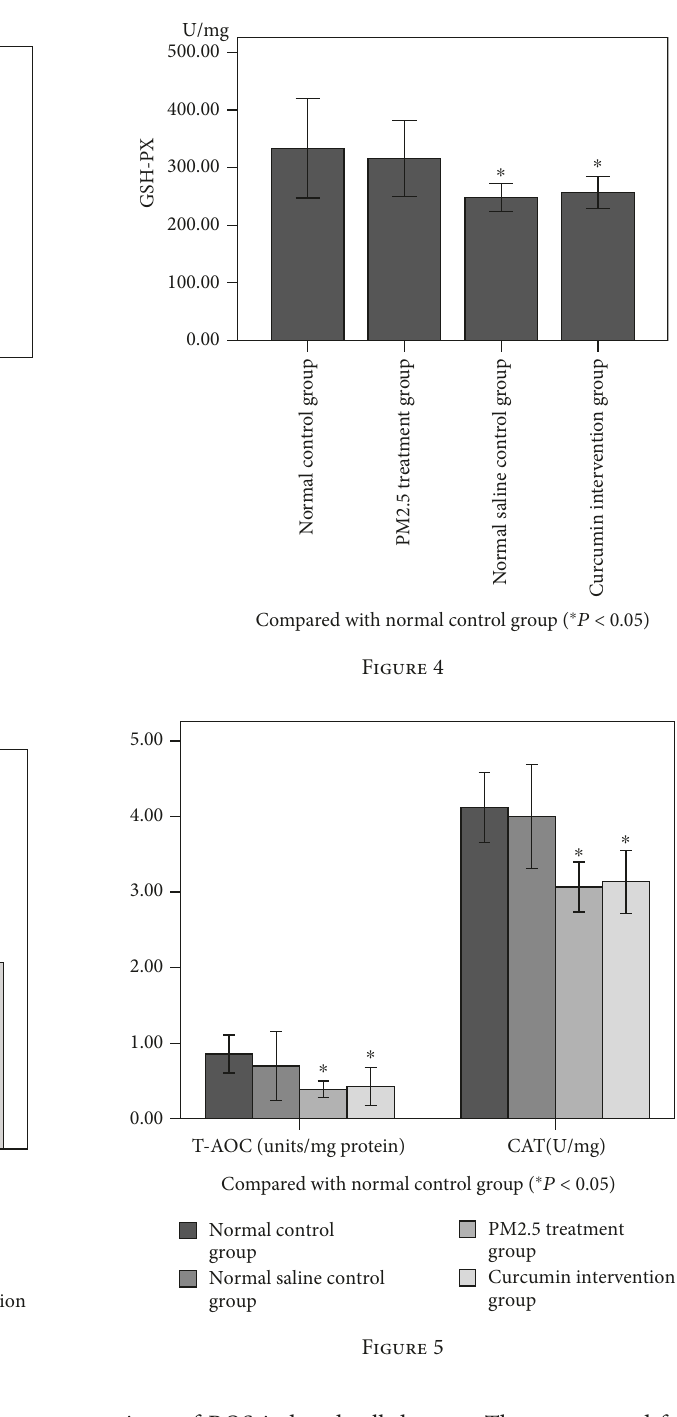
TNF 훼 PM2.5 treatment group Curcumin intervention